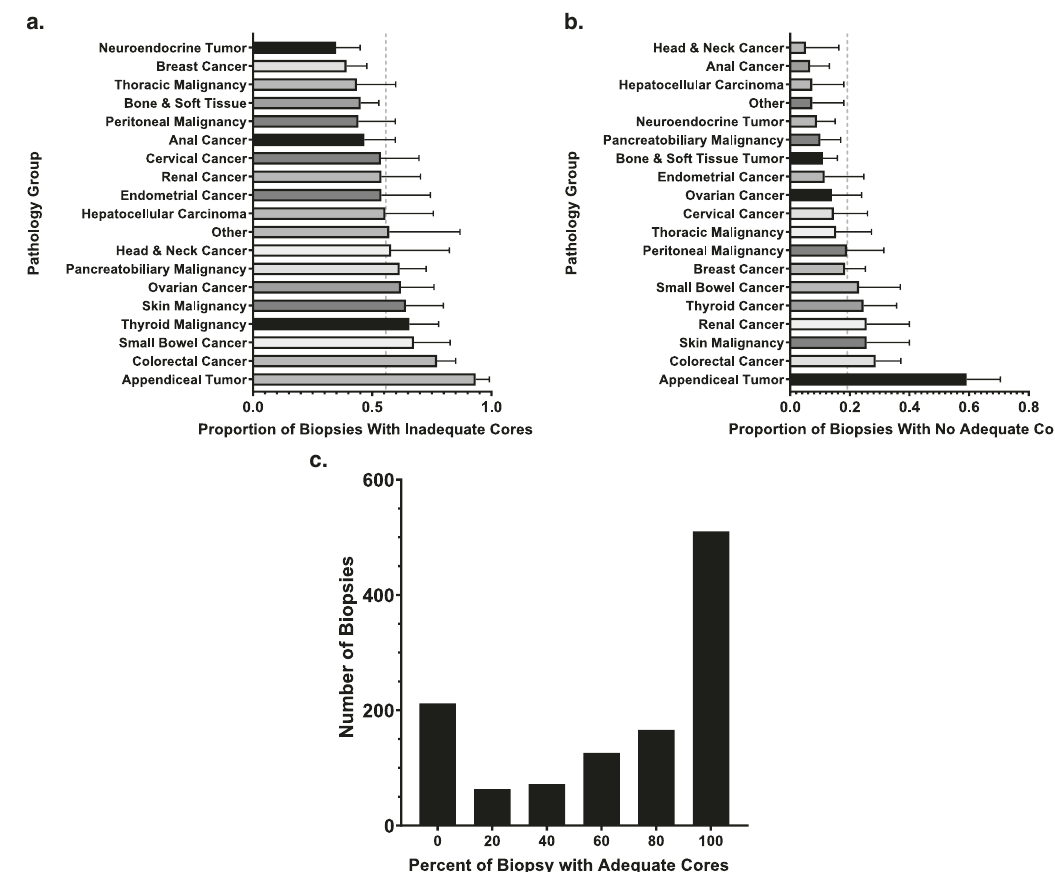
Fig. 1 Proportion of inadequate cores per biopsy. a The proportion of biopsies for each pathology group containing at least one inadequate core is displayed. The dotted line references the proportion of all biopsies with at least one inadequate core. b The proportion of biopsies for each pathology group containing no adequate cores is displayed. The dotted line references the proportion of all biopsies with no adequate cores. c Displays the distribution of inadequate cores per biopsy. Each bin refers to the proportion of the biopsy cores in a single biopsy that contains adequate (>10%) malignant cells. For example, if 3 out of 5 biopsy cores (60%) contained >10% malignant cell, it would be counted in the bin “ 60 – 79% ” .